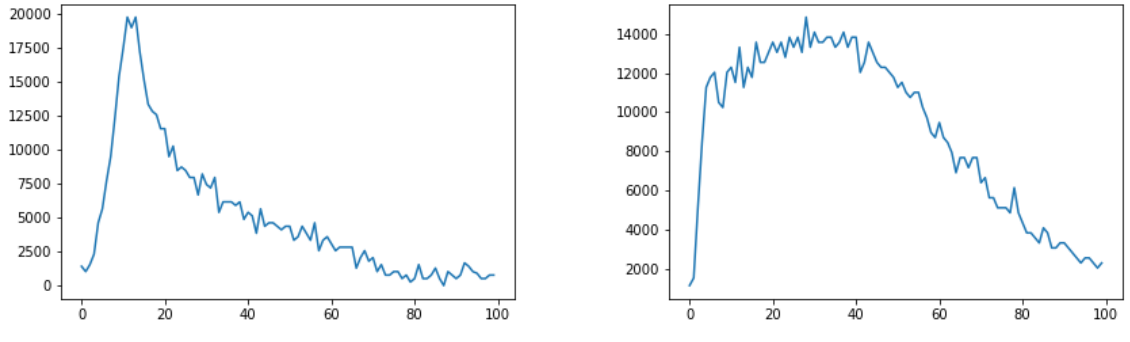
Figure 3. Examples of meteor echoes ATC: Underdense and overdense classes.